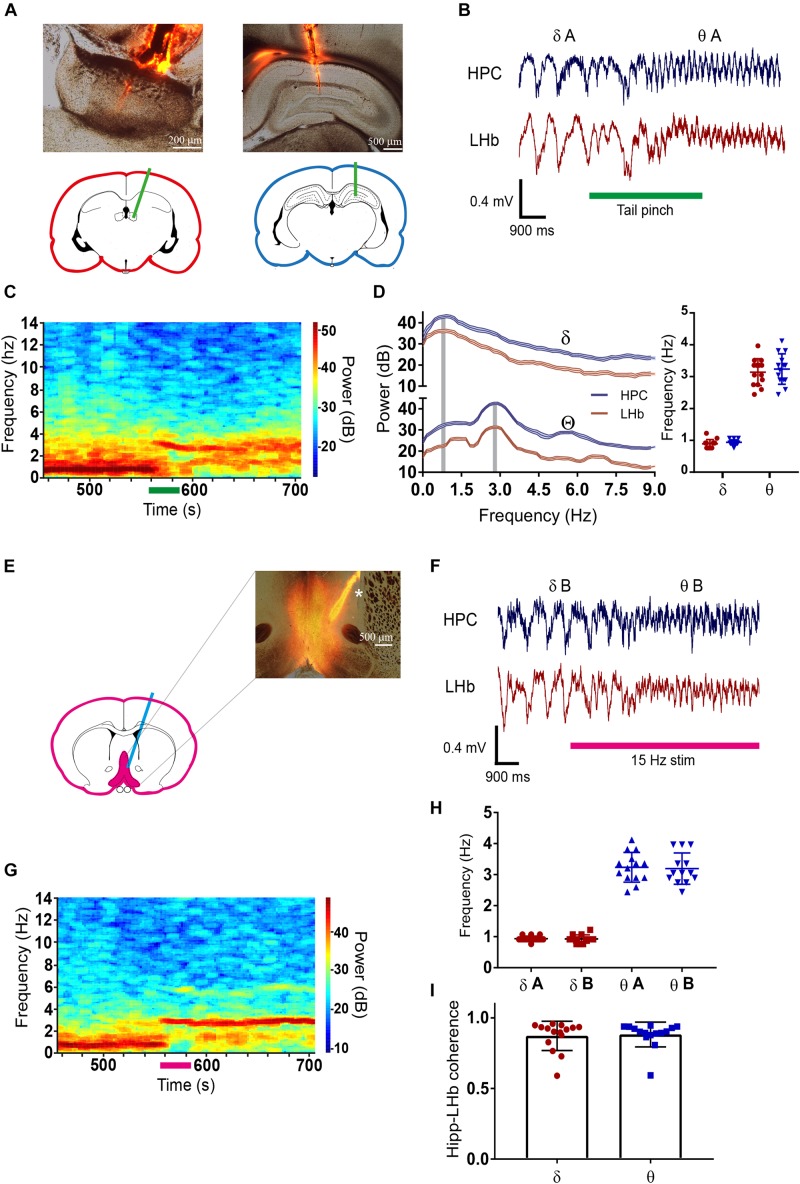
(A) Photomicrograph of the electrode location at the lateral habenula (LHb) (left) and the hippocampus (right). Electrodes were labeled with DiI to visualize their position by red fluorescence. Pictures are merged images of the transmitted light and the red fluorescence pictures. (B) Example of simultaneous field potential (FP) recording at the LHb and the hippocampus during tail pinch induced transition from delta (δA) to theta (θA). (C) Heat plot of the fast Fourier transform (FFT) of the FP at the hippocampus during the tail pinch-induced transition from delta to theta. Before the tail pinch FP was dominated by low frequencies, tail-pinch induced transition to theta range frequencies that persisted afterward. (D) Left average FFT of delta and theta periods at the LHb and the hippocampus, gray-shaded columns illustrate maximal frequencies for each state. Right, quantification of maximal frequencies for delta and theta at LHb and the hippocampus (delta state: 0.94 ± 0.08 and 0.89 ± 0.13 for the hippocampus and LHb, respectively; theta state: 3.24 ± 0.48 and 3.14 ± 0.42 for the hippocampus and LHb, respectively, N = 14 for all conditions). (E) Photomicrograph of the DBB/MS showing the infection with oChIEF-tdTomato encoding AAV and the tract of optic fiber used to light stimulation (∗labeled with DiI). Pictures are merged images of the transmitted light and the red fluorescence pictures. (F) Example of simultaneous FP recording at the LHb and the hippocampus during the transition from delta (δB) to theta (θB) induced by light stimulation of the DBB/MS complex in an oChIEF-tdTomato-infected animal. (G) Heat plot of FP FFT at the hippocampus during the transition from delta (δB) to theta (θB) induced by light stimulation of the DBB/MS complex in an oChIEF-tdTomato-infected animal. Before the tail pinch FP was dominated by low frequencies, 15 Hz light stimulation induced transition to theta range frequencies that persisted after stimulation finished. (H) Quantification of delta and theta frequencies at the hippocampus in experiments in oChIEF-tdTomato-infected and non-infected animals. There were no differences in delta and theta frequencies between both groups (mean frequencies for oChIEF: 0.93 ± 0.14, N = 13 for delta and 3.19 ± 0.4 Hz, n = 13 for theta; the non-infected group is the hippocampus group in (D). (I) Coherence between hippocampal and LHb FP’s at delta and theta. For all figures data represent mean ±SD.